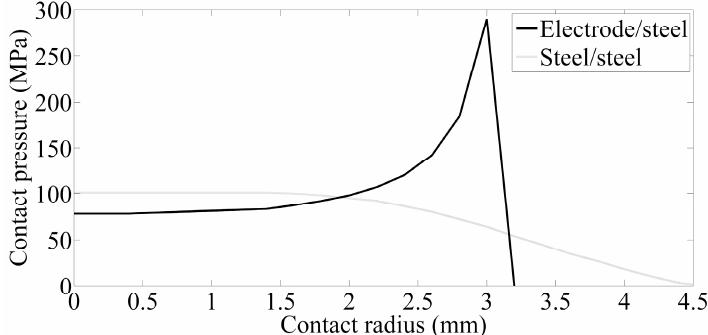
Figure 10. Contact pressure distribution of the welding joints in the squeeze stage.